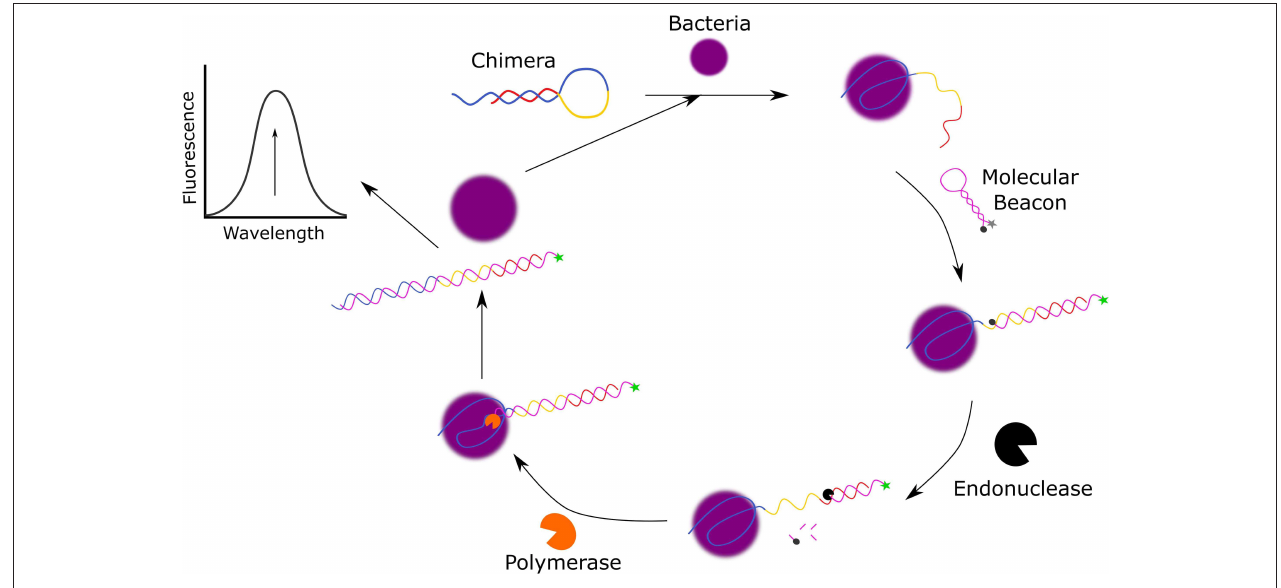
FIGURE 3 | Schematic diagram of the fluorescent detection of S. aureus using molecular beacon-controlled signal amplification (Cai et al., 2019).